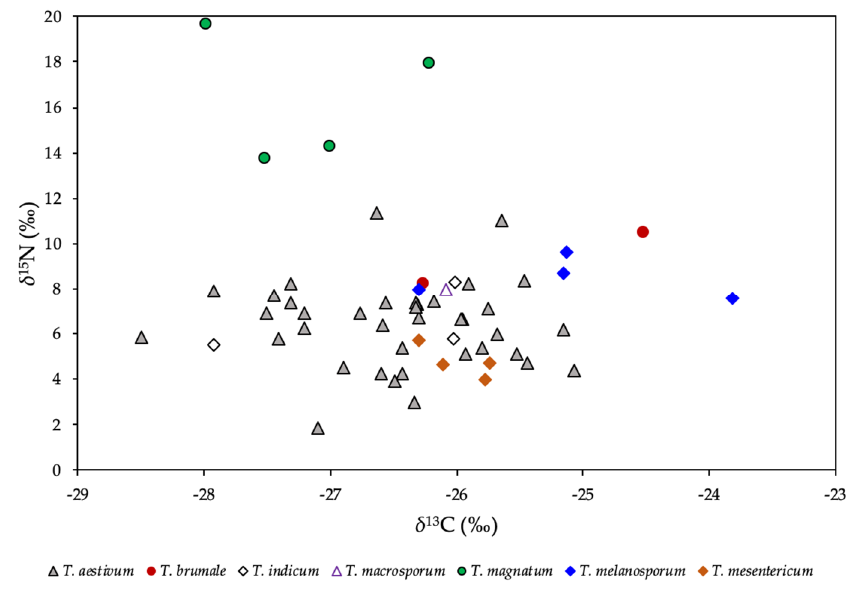
Figure 4. Relationship between δ 15 N and δ 13 C values in Tuber species.